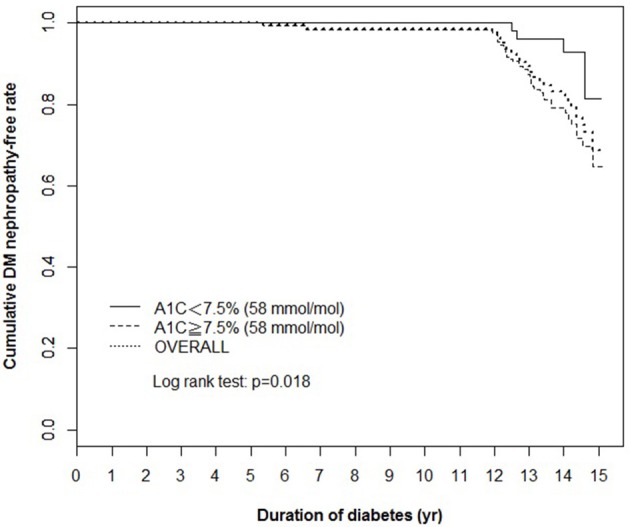
Kaplan–Meier cumulative survival curve of the total population (overall) and the population stratified according to the average HbA1c levels in last 5 years [<7.5% (58 mmol/mol) and ≥7.5% (58 mmol/mol)]. The cumulative survival rate of DN-free patients is plotted against the follow-up duration in years. The log-rank test was performed to compare the two groups. The dotted line represents the entire group, and the solid and dashed lines represent the two comparison groups in each figure. DN, diabetic nephropathy.